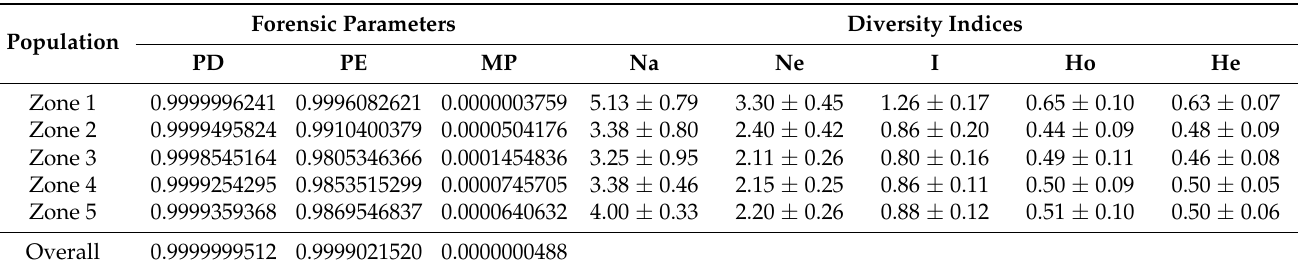
Table 4. Forensic parameters and diversity indices values (mean ± SE) for leatherback turtles in the Andaman Sea based on eight microsatellite loci across five regional